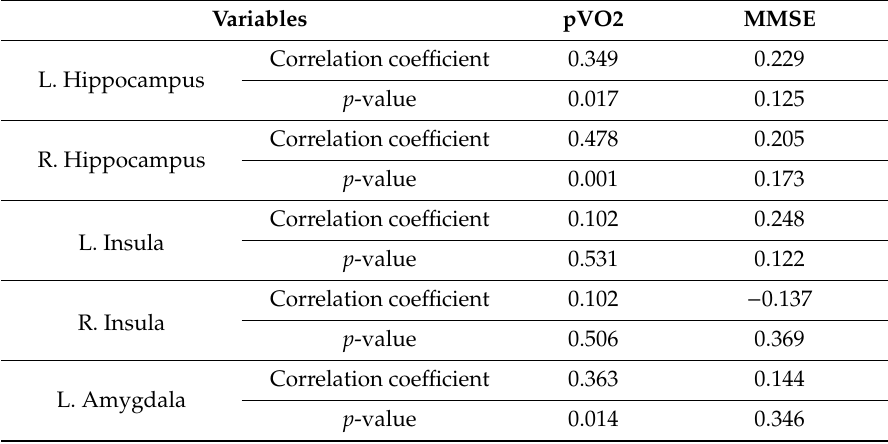
Table 4. Relationships between the pVO2, the MMSE, and the brain structure